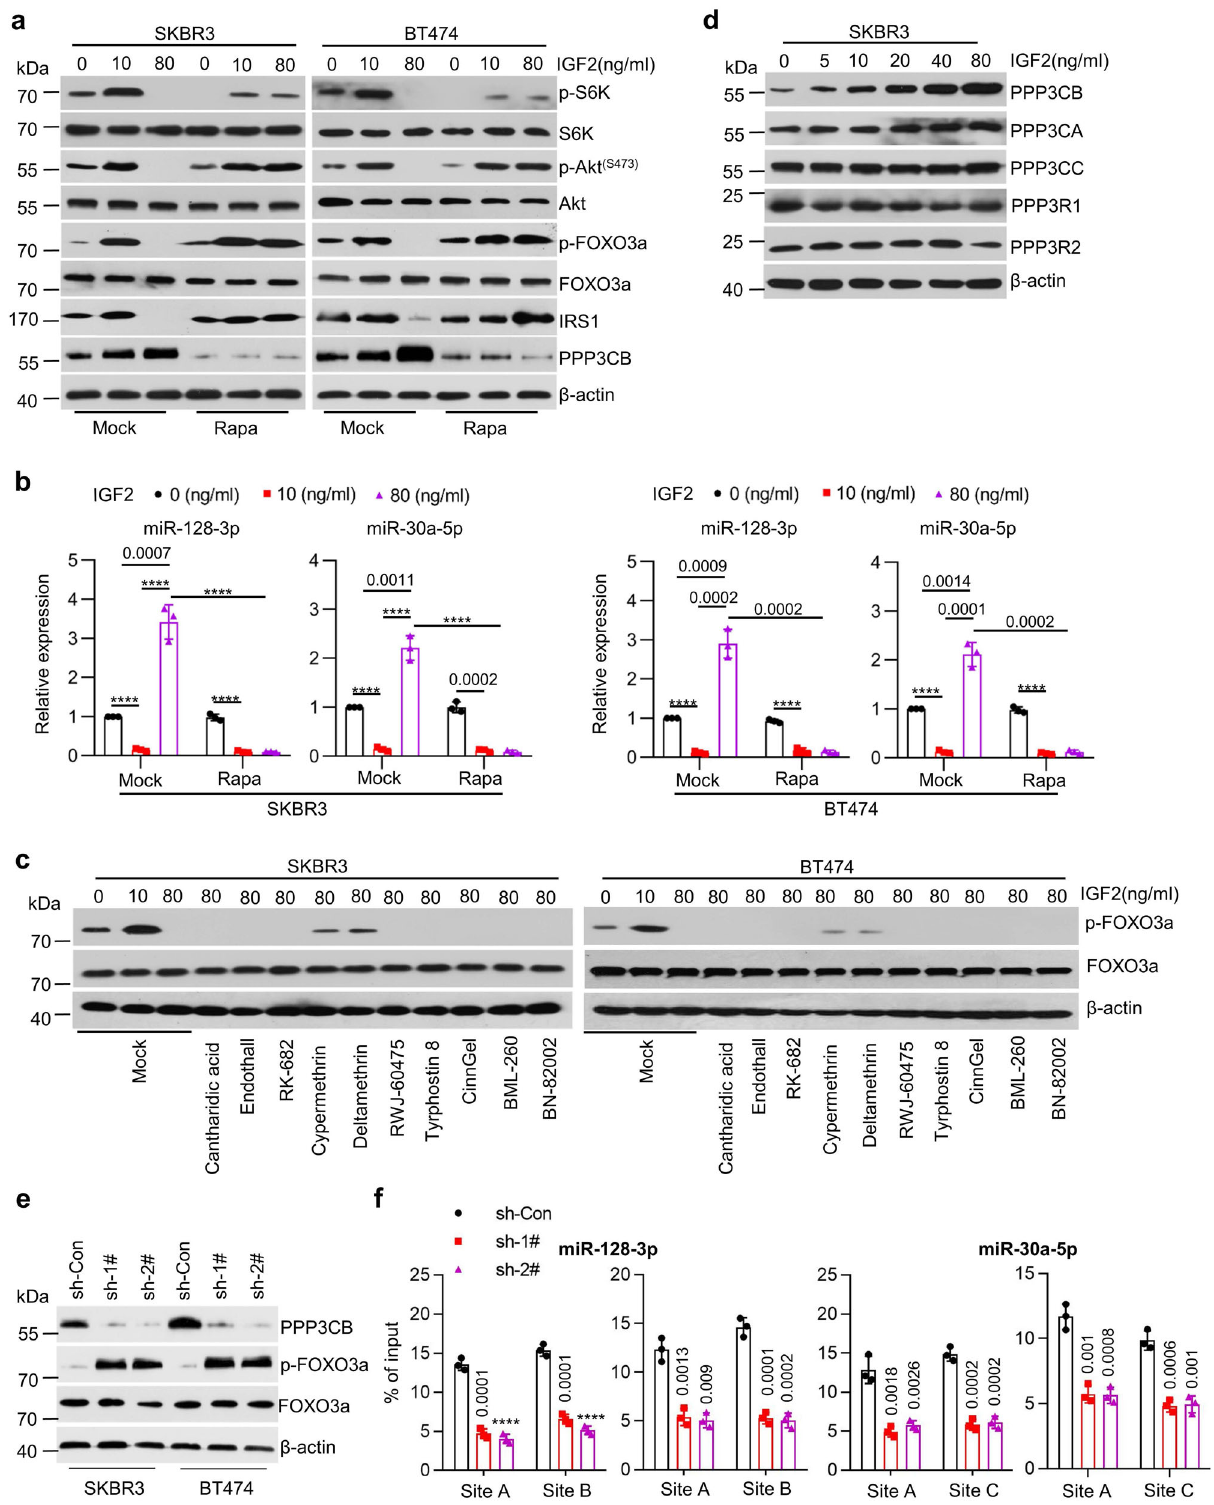
Herceptin against the parental cells (Fig. 6b and Supplementary Fig. 6a). In addition, ectopic expression of PPP3CB dramatically decreased p-FOXO3a and IRS1, and markedly reduced IGF2 levels in the CM of Herceptin-resistant cells (Fig. 6c). Meanwhile, over- expression of PPP3CB signi fi cantly upregulated miR-128-3p, miR-30a-5p, and miR-193a-5p in the resistant cells (Fig. 6d).